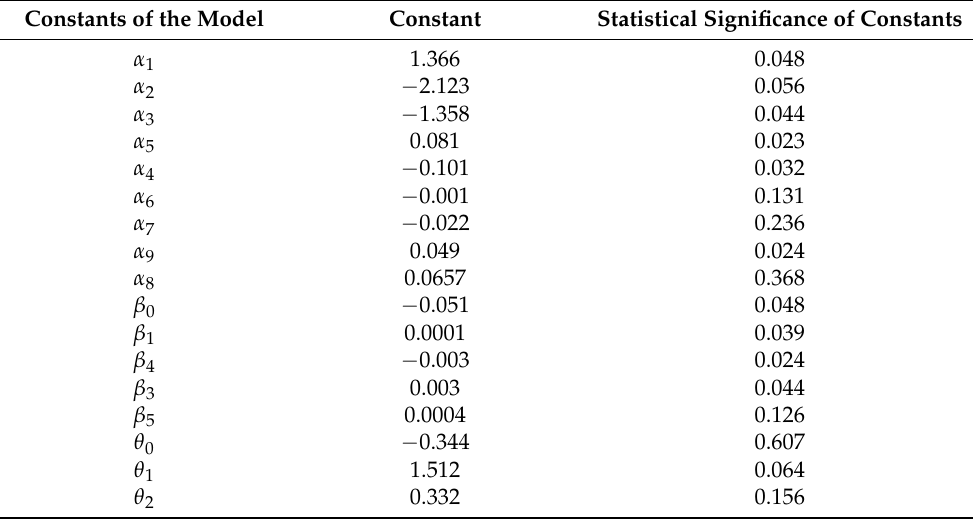
Figure 1. Graphical interpretation of initial data for estimating energy efficiency gaps in Ukraine, 2000–2019.